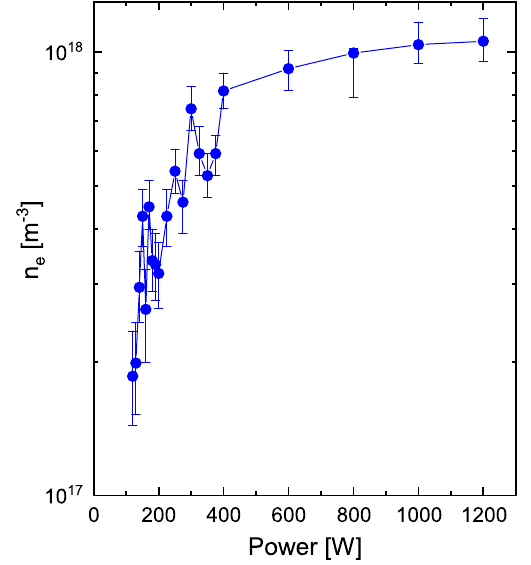
FIG. 4. Electron density evaluated via OES when increasing the rf power.